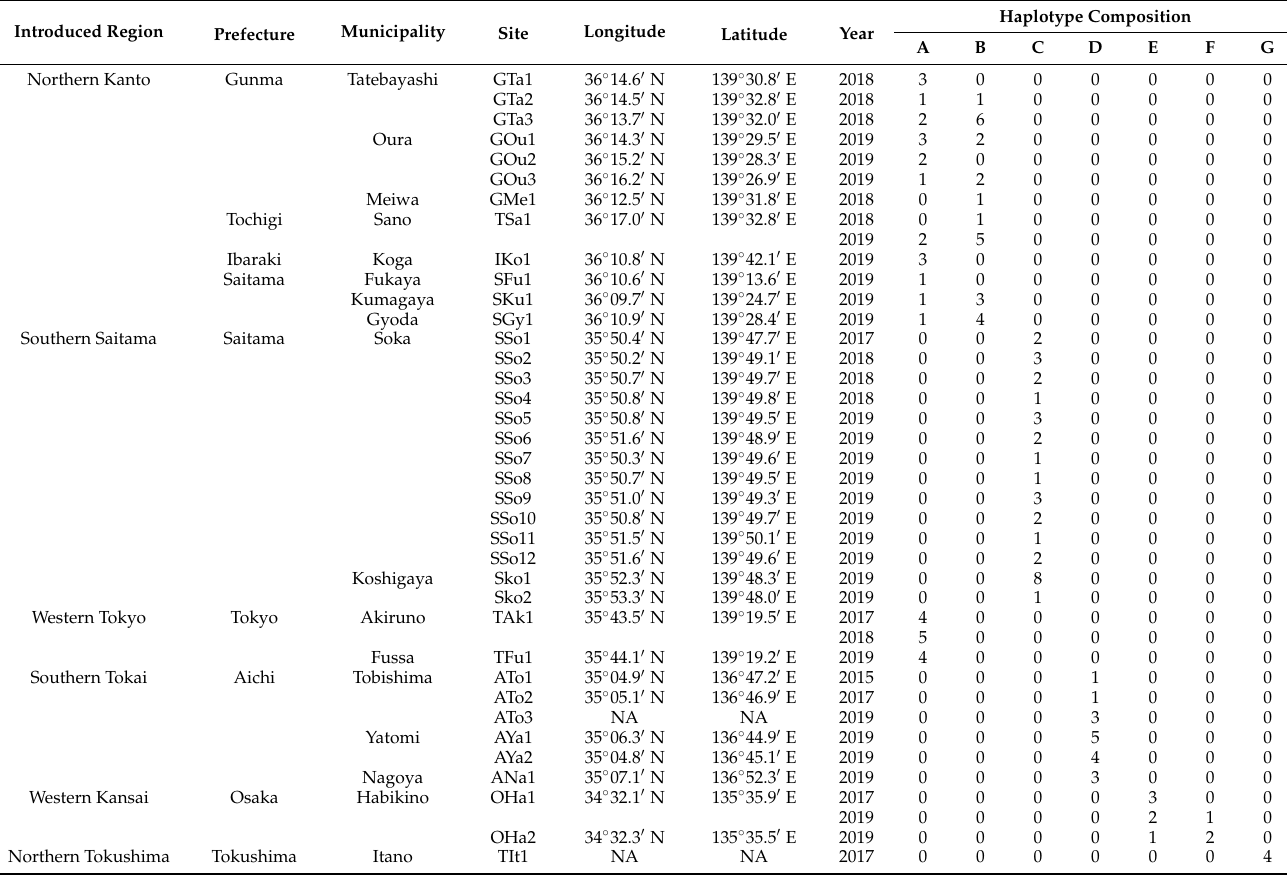
Table 1. Sampling information and haplotype compositions of Aromia bungii